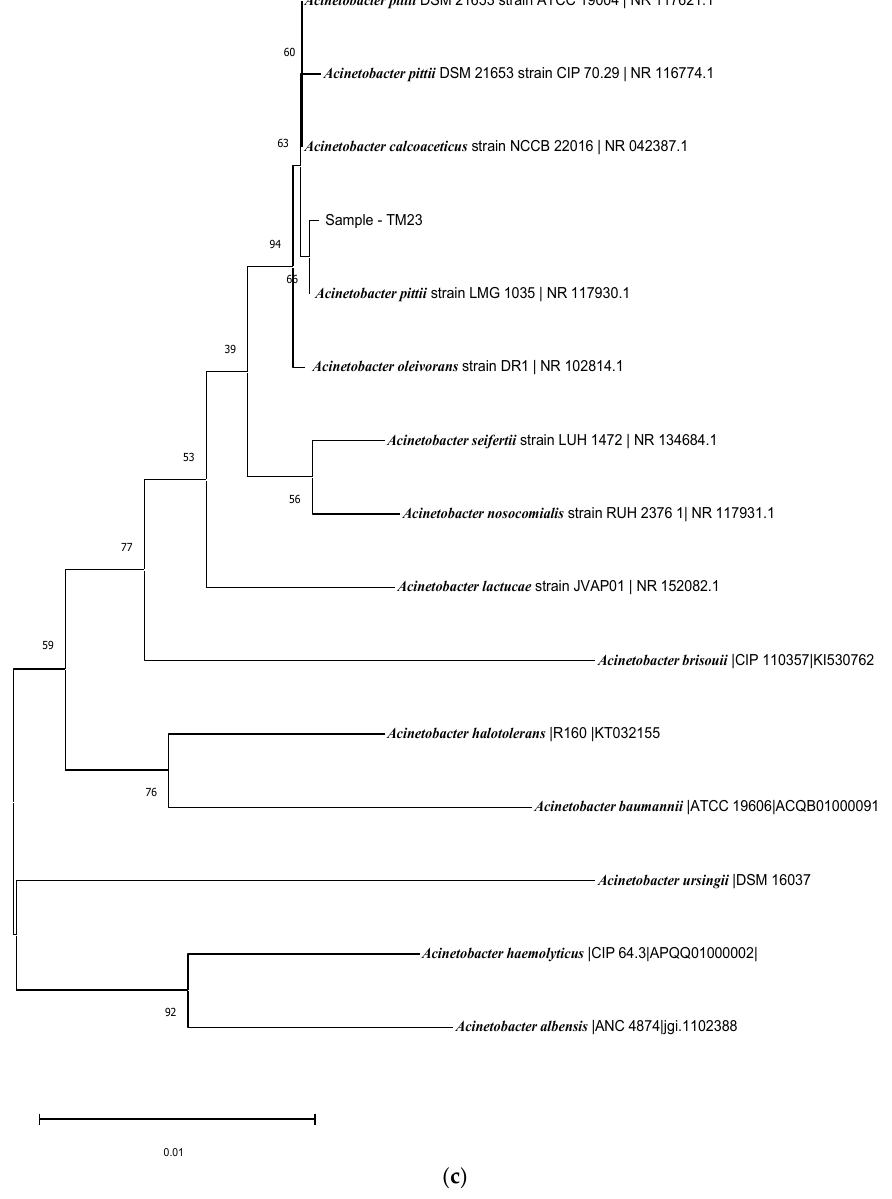
Figure 4. ( a ) Phylogenetic tree of isolate TM56. ( b ) Phylogenetic tree of isolates TM13 and TM9. ( c ) Phylogenetic tree of isolate TM23.